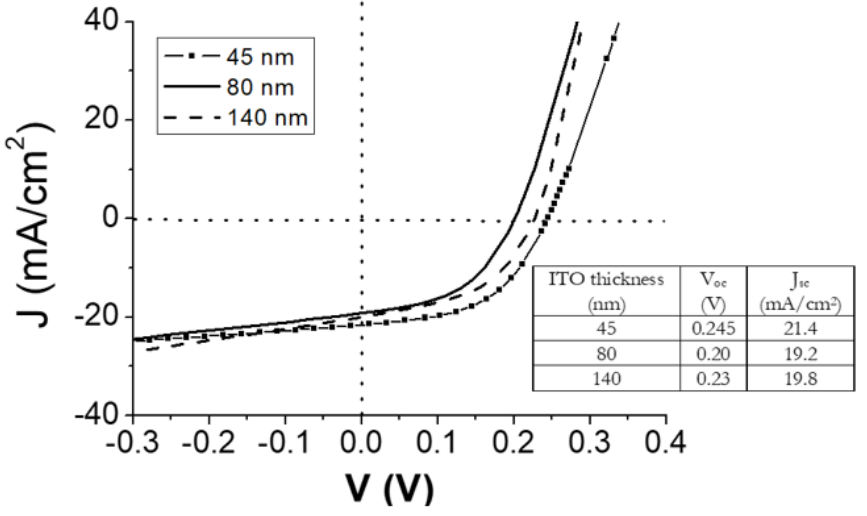
Figure 3. J ‐ V characteristics measured under illumination of the photocells fabricated with ITO thin films with different thickness. In the inset, the table with the electrical parameters V OC and J SC .